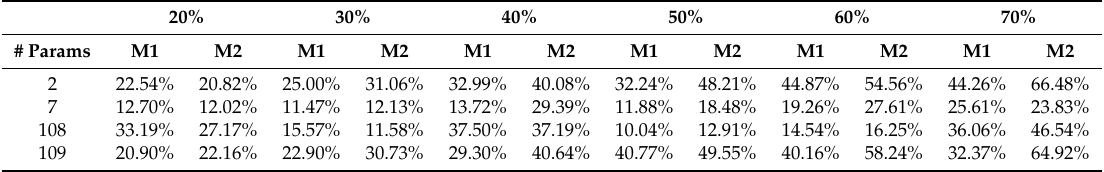
Table 3. Different parametrisations for the combination model. Performance was measured on single runs with varied classifier accuracy levels (top